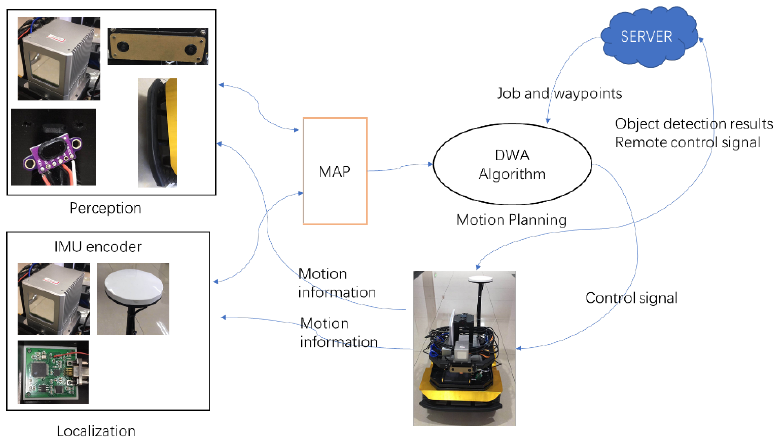
Figure 8. Navigation